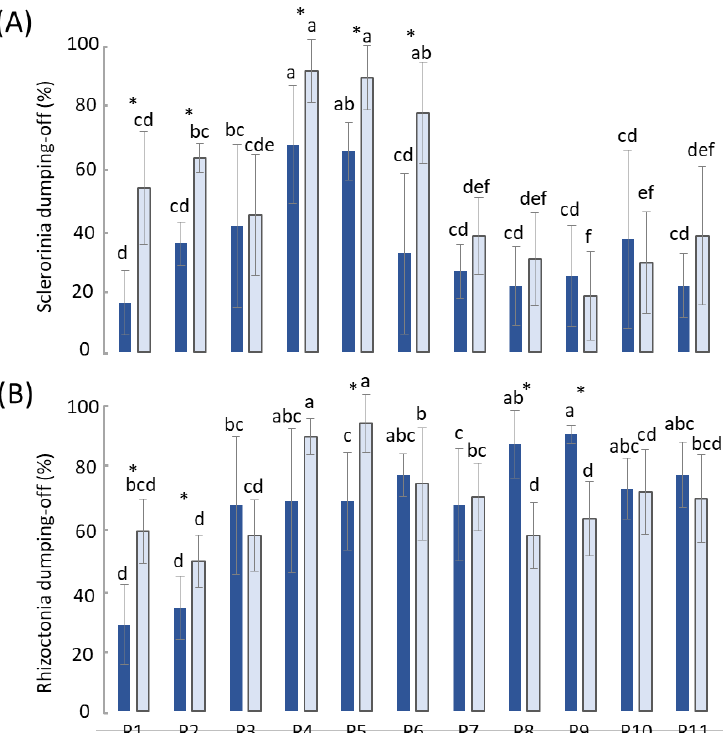
Figure 2. Percentage of Sclerotinia ( A ) and Rhizoctonia ( B ) damping-off on cress seedlings in raw (dark blue bars) and autoclaved (light blue bars) composts diluted into peat. Lowercase lettering indicates significant differences ( p ≤ 0.05), according to the Least Significant Difference post hoc test, among both the raw and autoclaved samples. Asterisk indicates significant differences ( p ≤ 0.05), according to the Least Significant Difference post hoc test, between the raw and autoclaved samples of the same compost.